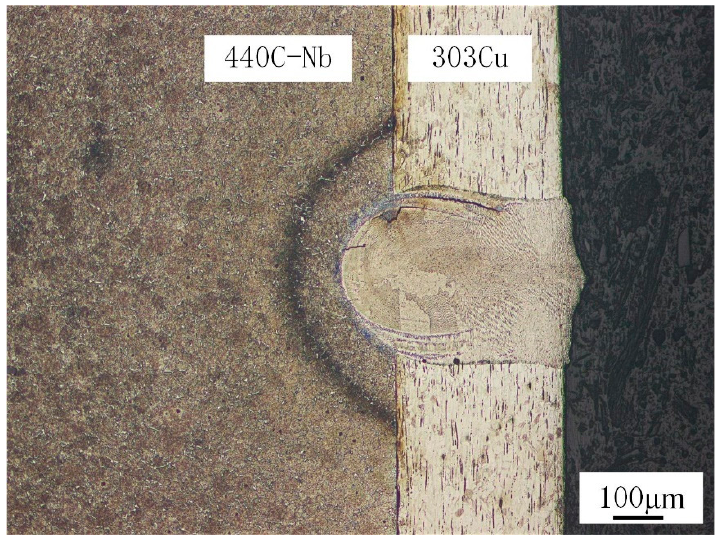
( b ) Figure 7. Numerical simulation comparison and temperature field simulation results: ( a ) Compari- son of simulation and experimental results; ( b ) temperature field simulation results.